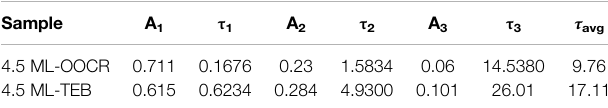
TABLE1| Thelifetimeof4.5 MLZBCdSeNPLscappedwithRCOO − orTEB(ns).